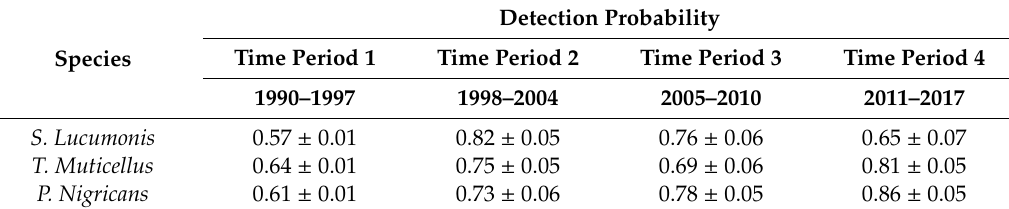
Table 3. Probability of detection ( ± standard error (SE)) across the four time periods for Squalius lucumonis , Telestes muticellus and Padogobius nigricans.